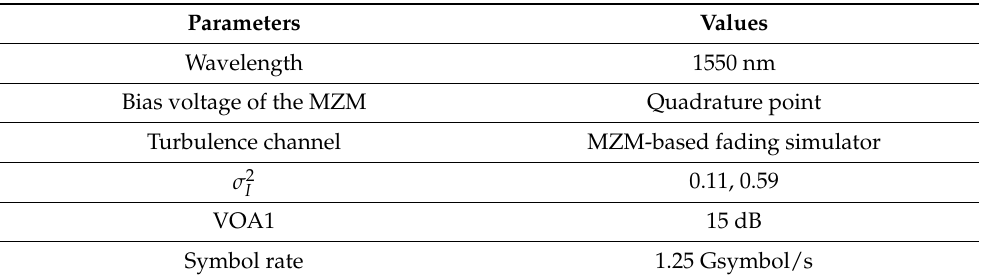
Table 1. Parameters used in the experiments.